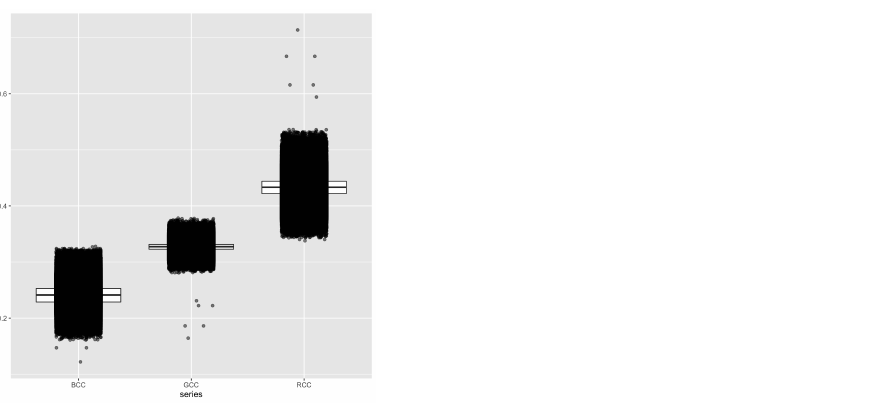
Figure 17. Boxplots of chromatic coordinates showing all underlying pixels and outliers.